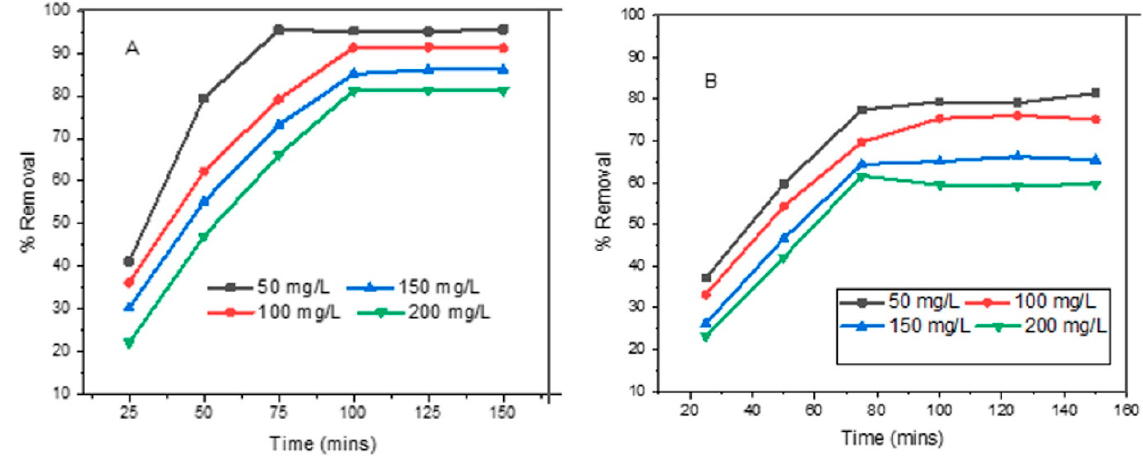
Figure 4. Effect of initial dye concentration and contact time ( A ) Native GP ( B ) Washed GP.